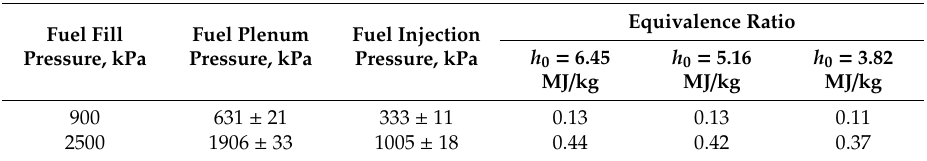
Table 3. Fuel injection